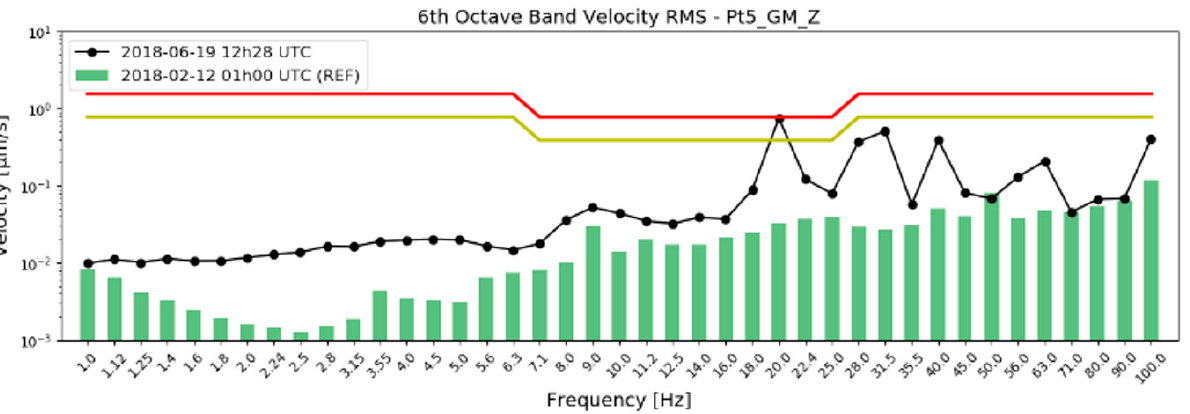
Figure 3. Example of warning and alarm levels shown as the 1/6th Octave Band Velocity RMS for a 20-min data block, correlation of data from typical night and measurement while commercial compactor was working on the surface just above the seismic station [15].